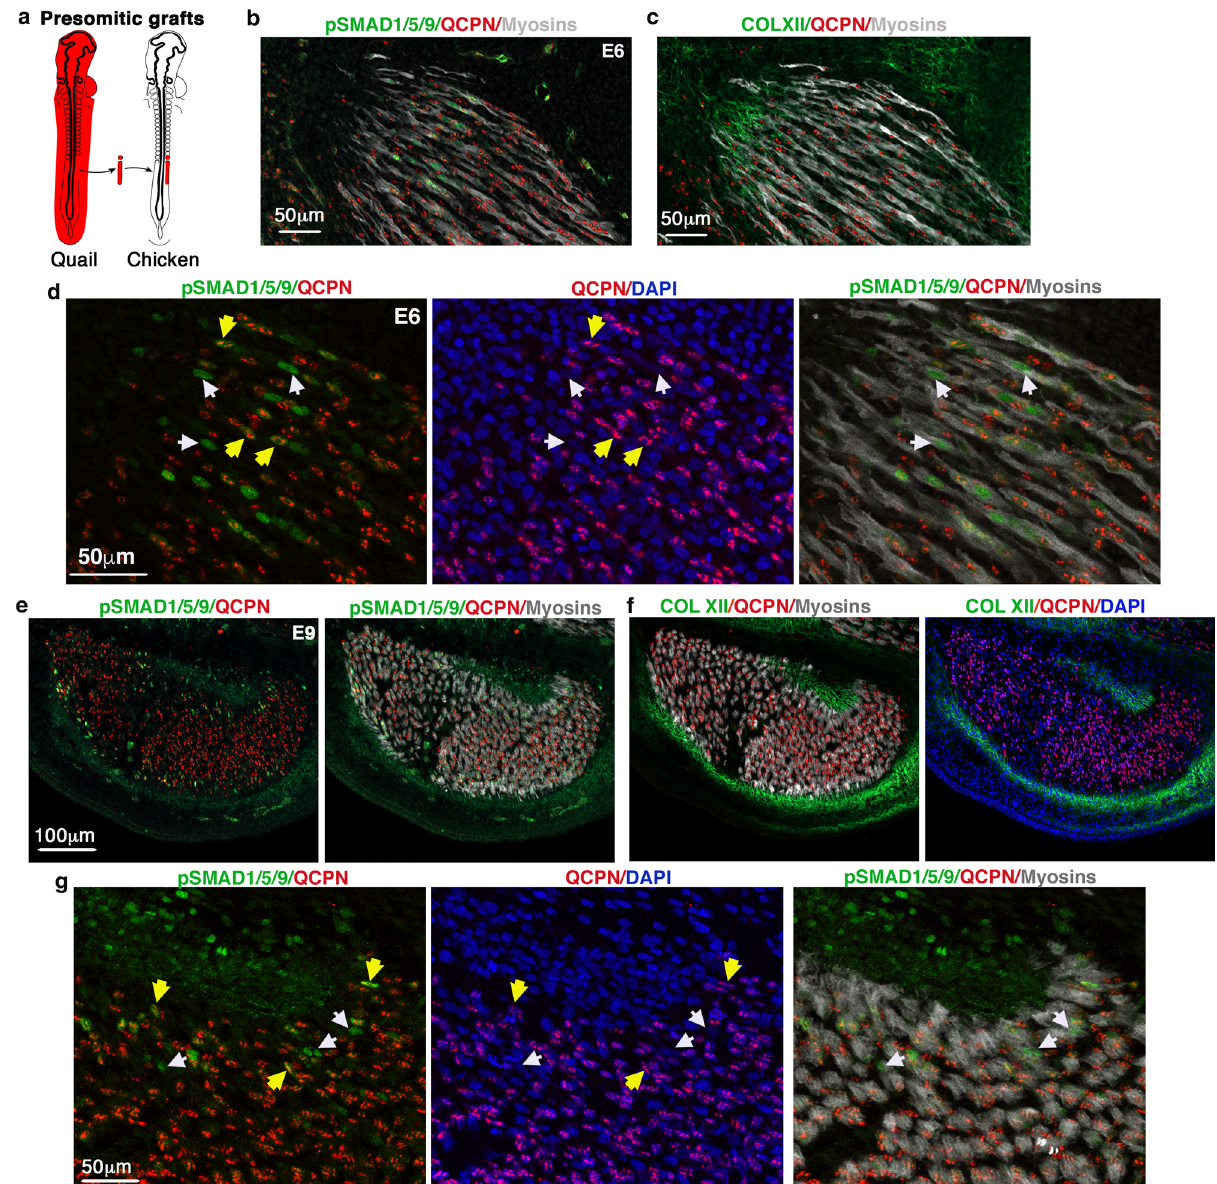
Fig. 6 PSMAD1/5/9 + myonuclei label two myonucleus populations of distinct embryological origins at muscle tips. a Schematic of isotopic presomitic mesoderm grafts from quail to chicken embryos. b Longitudinal view of a limb muscle from E6 chimera labelled with pSMAD1/5/9 (green), QCPN (quail nuclei, red) and MF20 (myosins, grey) antibodies, with a focus on muscle tips. c Adjacent section to b labelled with COLXII (tendon, green), QCPN (quail nuclei, red) and MF20 (myosins, grey) antibodies. d Focus on muscle tips, labelled with pSMAD1/5/9 (green), QCPN (quail nuclei, red) and MF20 (myosins, grey) antibodies, combined with DAPI (blue). White arrows point to pSMAD1/5/9 + myonuclei (green) that are not of quail origin (QCPN − ), while yellow arrows point to pSMAD1/5/9 + myonuclei (green) that are of quail origin (QCPN + , red). e Transverse view of the FCU muscle from E9 chimera labelled with pSMAD1/5/9 (green), QCPN (quail nuclei, red) and MF20 (myosins, grey) antibodies. f Adjacent section to e labelled with COLXII (tendon, green), QCPN (quail nuclei, red) and MF20 (myosins, grey) antibodies, combined with DAPI. g Focus on muscle tips. White arrows point to pSMAD1/5/9 + myonuclei (green) that are not of quail origin (QCPN − ), while yellow arrows point to pSMAD1/5/9 + myonuclei (green) that are of quail origin (QCPN + ,